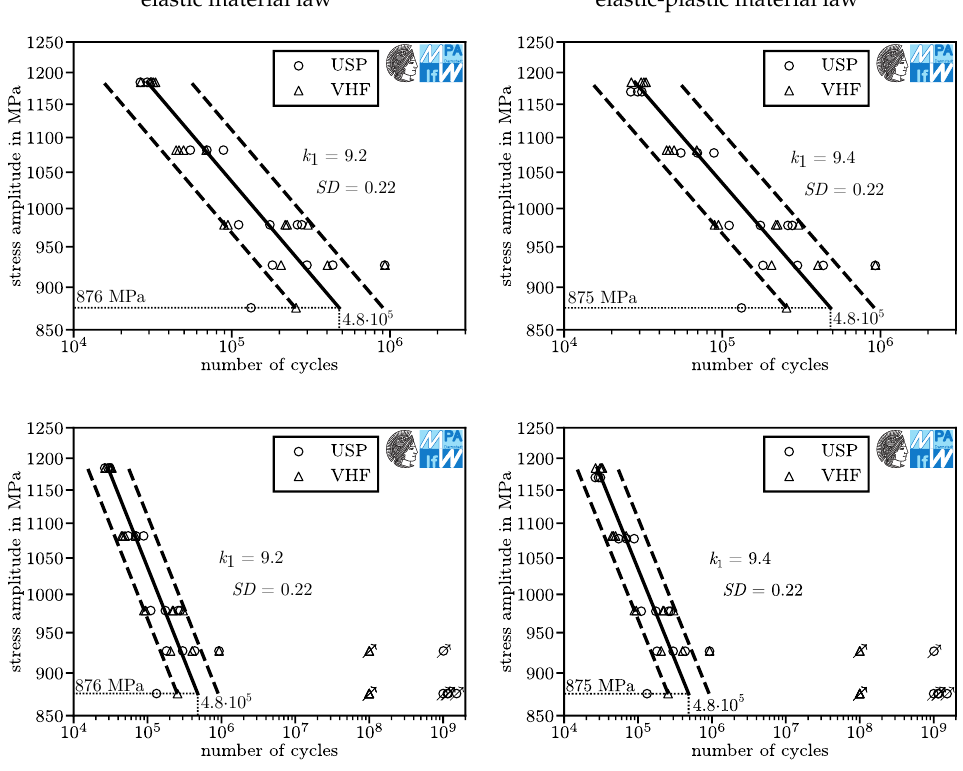
Figure 13. Fatigue behavior of 50CrMo4 in laboratory air; 1726MPa ultimate tensile strength; K t = 2.06; run-outs are marked with an arrow; left side: before correction; right side: after correction; top: only HCF region; bottom: including VHCF